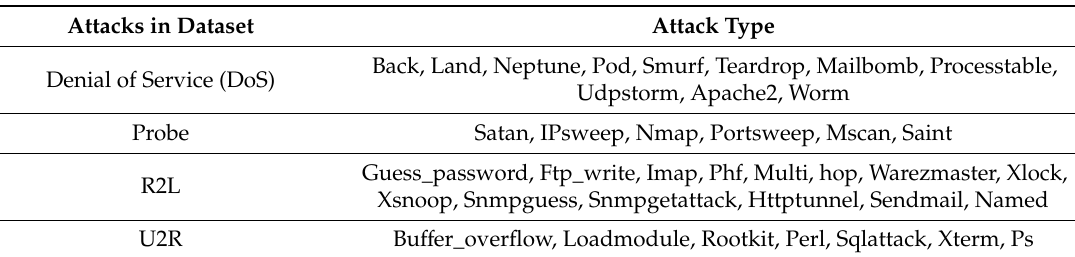
Table 3. Symbols